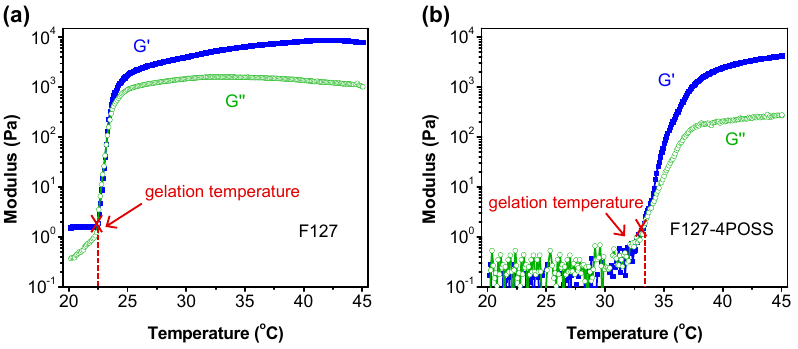
Figure 3. Oscillatory temperature sweep showed storage ( G ’) and loss modulus ( G ’’), and gelation temperature of 15 wt % ( a ) F127 and ( b ) F127-POSS, between 20–45 °C, at a ramp rate of 1 °C·min − 1 , under constant strain of 1.25%, and angular frequency of 10 rad·s − 1 .